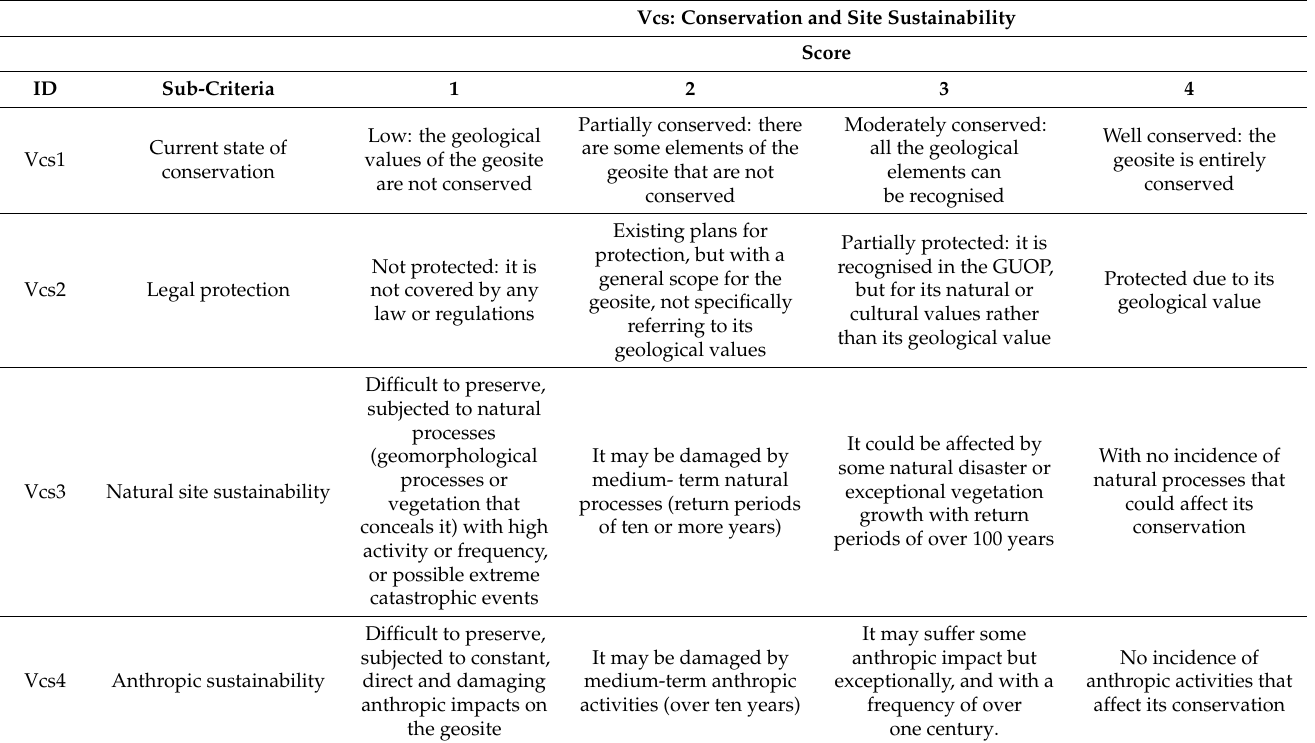
Table 5. Conservation and site sustainability and sub-criteria